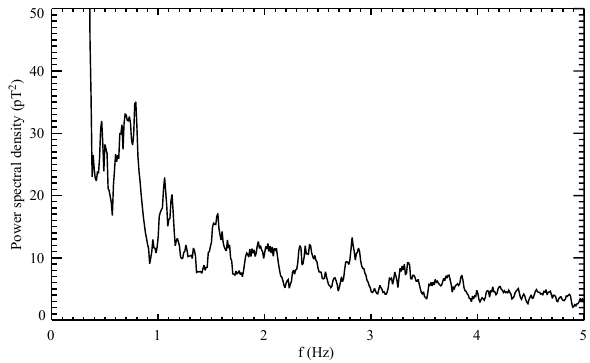
Figure 3. Calibrated D component magnetic power spectral density for Fig. 3. Power spectral density for 18:00–18:40 UT from pulsation 1800-1840 UT on 04/10/98 for window and slip size 100 s. This is the magnetometer at Sodankyl¨a, Finland on 4 October 1998 for window average of 24 power spectra, smoothed with a boxcar of width 3. and slip size of 100s. This is the average of 24 power spectra, smoothed with a boxcar of width